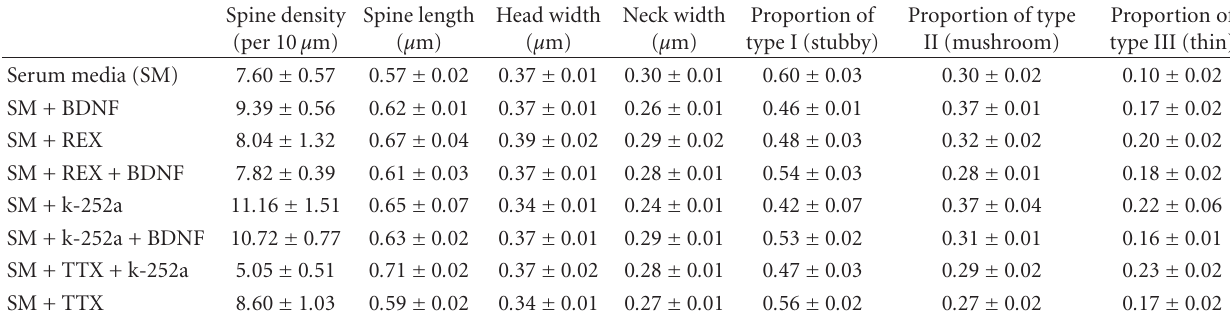
Table 1: Quantitative results of dendritic spine analyses.